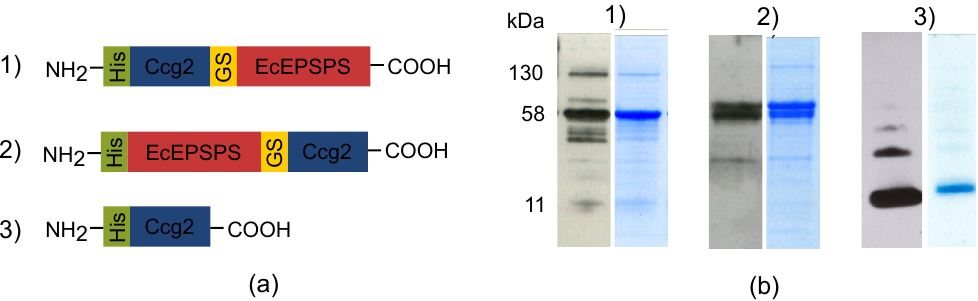
Figure 1. Utilized proteins for this study. ( a ) Schematic representation of Ccg2 and Ccg2-EPSPS fusion proteins; ( b ) Western blots (left lanes) and Coomassie stained gel strips (right lanes) after expression and purification of the proteins. For Western blot analysis the samples were electrophoretically separated, subsequently transferred to a PVDF membrane and probed with 6xHis monoclonal-antibody. Molecular masses (kDa) are indicated on the left. The molecular masses of the fusion proteins (1 + 2) and Ccg2 (3) are ca. 58 kDa and 11 kDa,